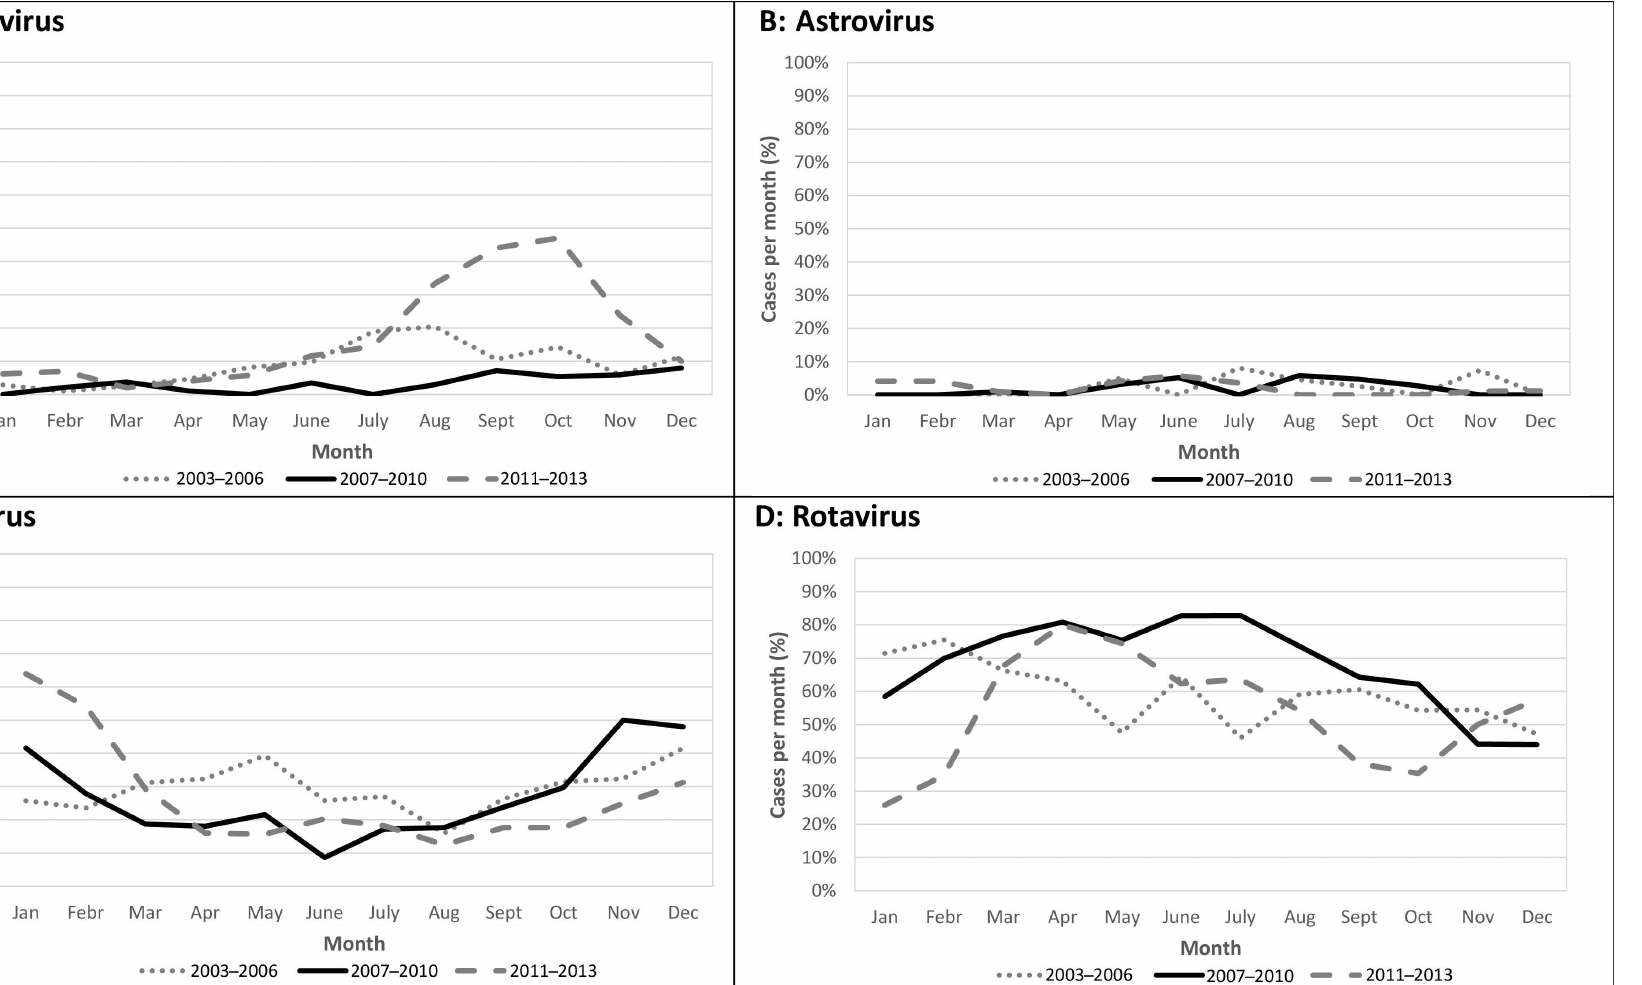
Figure 1. Seasonality of paediatric acute gastroenteritis (number of cases per month/total viral cases per month *100) stratified by causative virus (( A ): Adenovirus, ( B ): Astrovirus, ( C ): Norovirus, ( D ): Rotavirus) and study period (2003–2006, 2007–2010, 2011–2013).